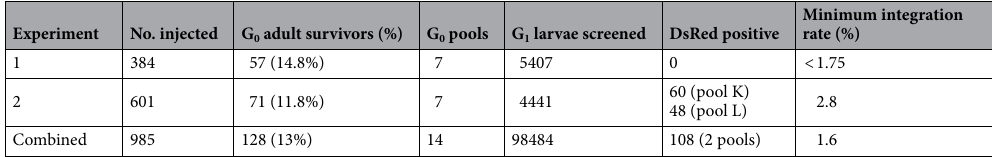
Table 1. Results of two sets of injection experiments aiming to integrate a knock-in cassette into the kmo locus. Culex wild-type embryos co-injected with AGG2069 HDR donor plasmid, LA935 sgRNA and SpCas9 protein. Adult injection survivors were mated in the number of pools indicated. These were blood fed and four ovipositions collected and larvae screened for DsRed fluorescence. Integration rate is calculated by dividing the number of pools which yield an integration event (here 2) by the total number of G 0 adults. For experiment 1, minimum integration rate was calculated as being less than that which would have been achieved if 1 positive G 1 had been observed.